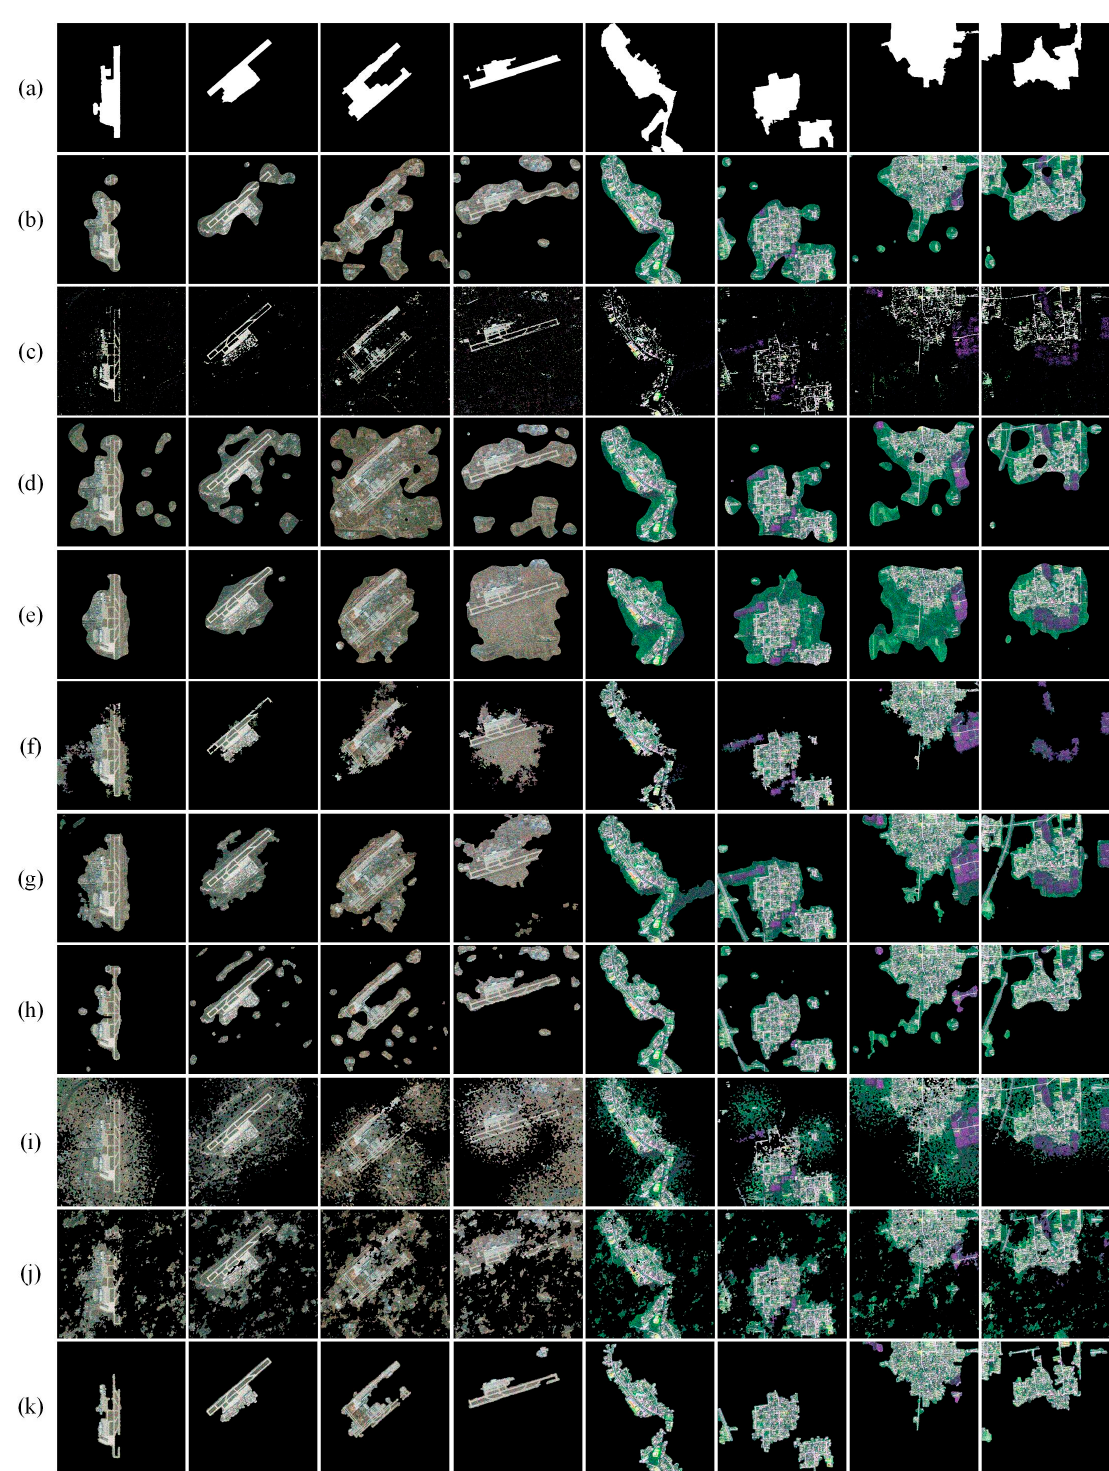
Figure 13. Comparison of ROIs for images polluted by Gaussian noise (Standard Variance = 0.05) (first four images are from the SPOT5 satellite and last four are from Google Earth): ( a ) ground truth; ( b ) SR; ( c ) FT; ( d ) ITTI; ( e ) GBVS; ( f ) H; ( g ) CA; ( h ) FDA; ( i ) WT; ( j ) MFF; and ( k ) LI.